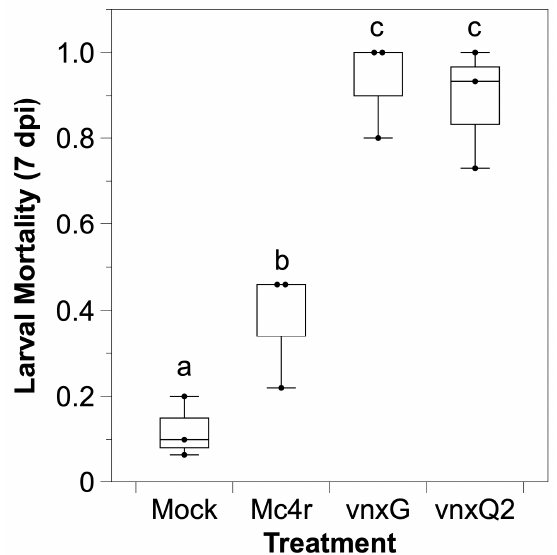
Figure 2. Vinnexin expression leads to higher mortality during NPV infection. Early 4th instar larvae were injected with 100 pfu recombinant viruses or media and inspected daily for one week for mortality. Superscript letters indicate significance after Bonferroni correction ( α′ = 0.0083).